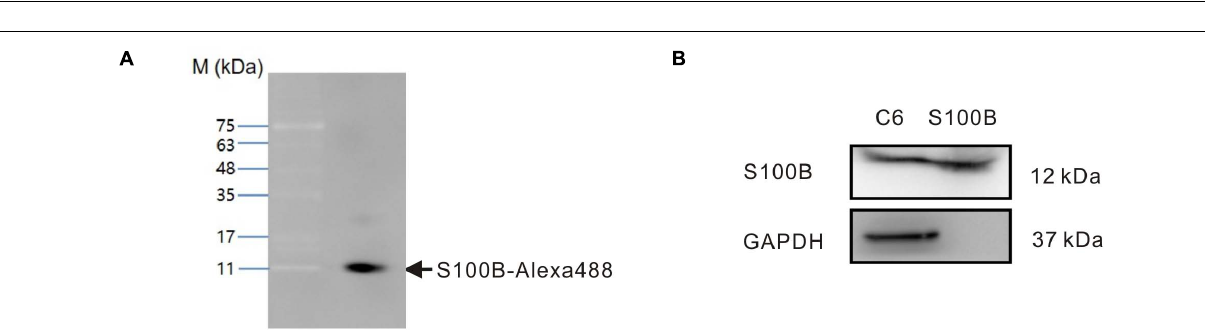
Frontiers in Cell and Developmental Biology |